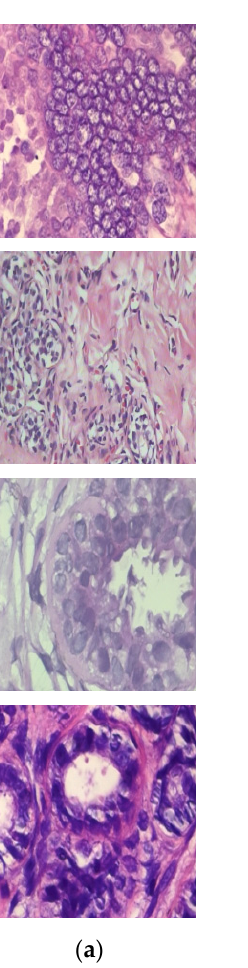
Figure 10. The segmentation results of the proposed method: ( a ) the input images; ( b ) segmented results of our method.